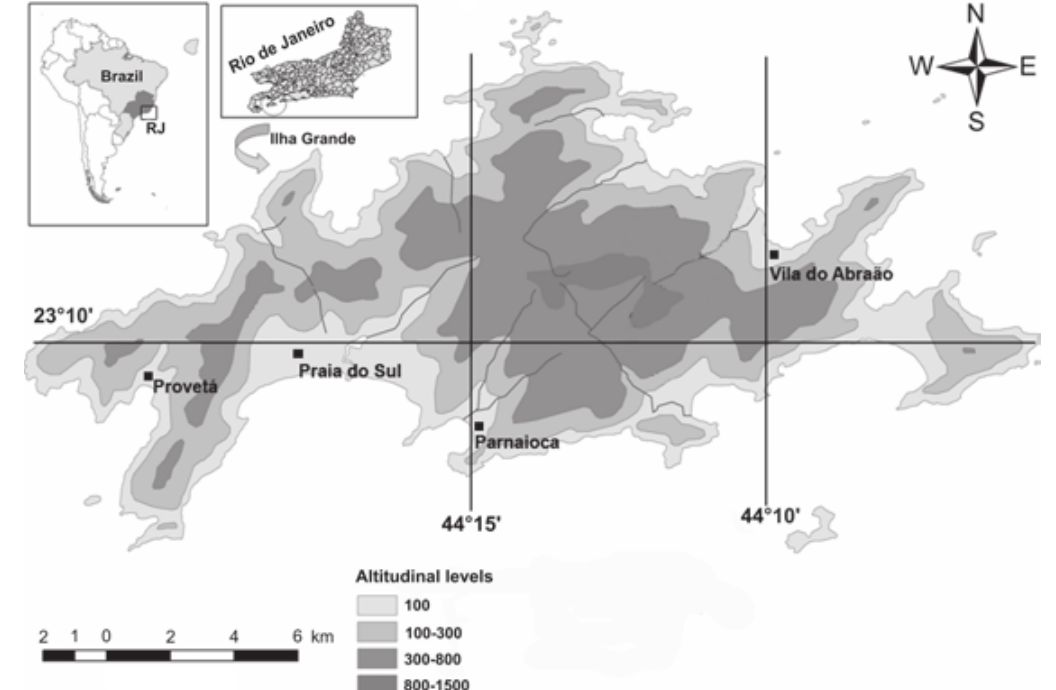
Figure 1. Location of Ilha Grande showing the four collecting